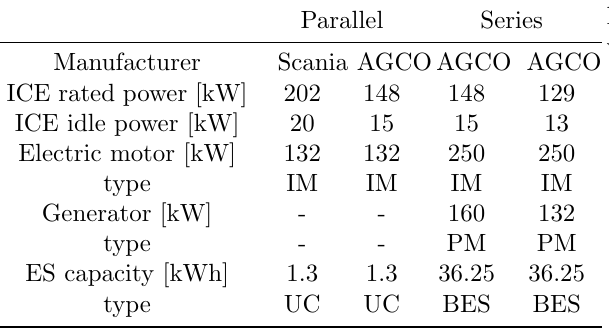
Table 1: The component dimensions of the backhoe loader